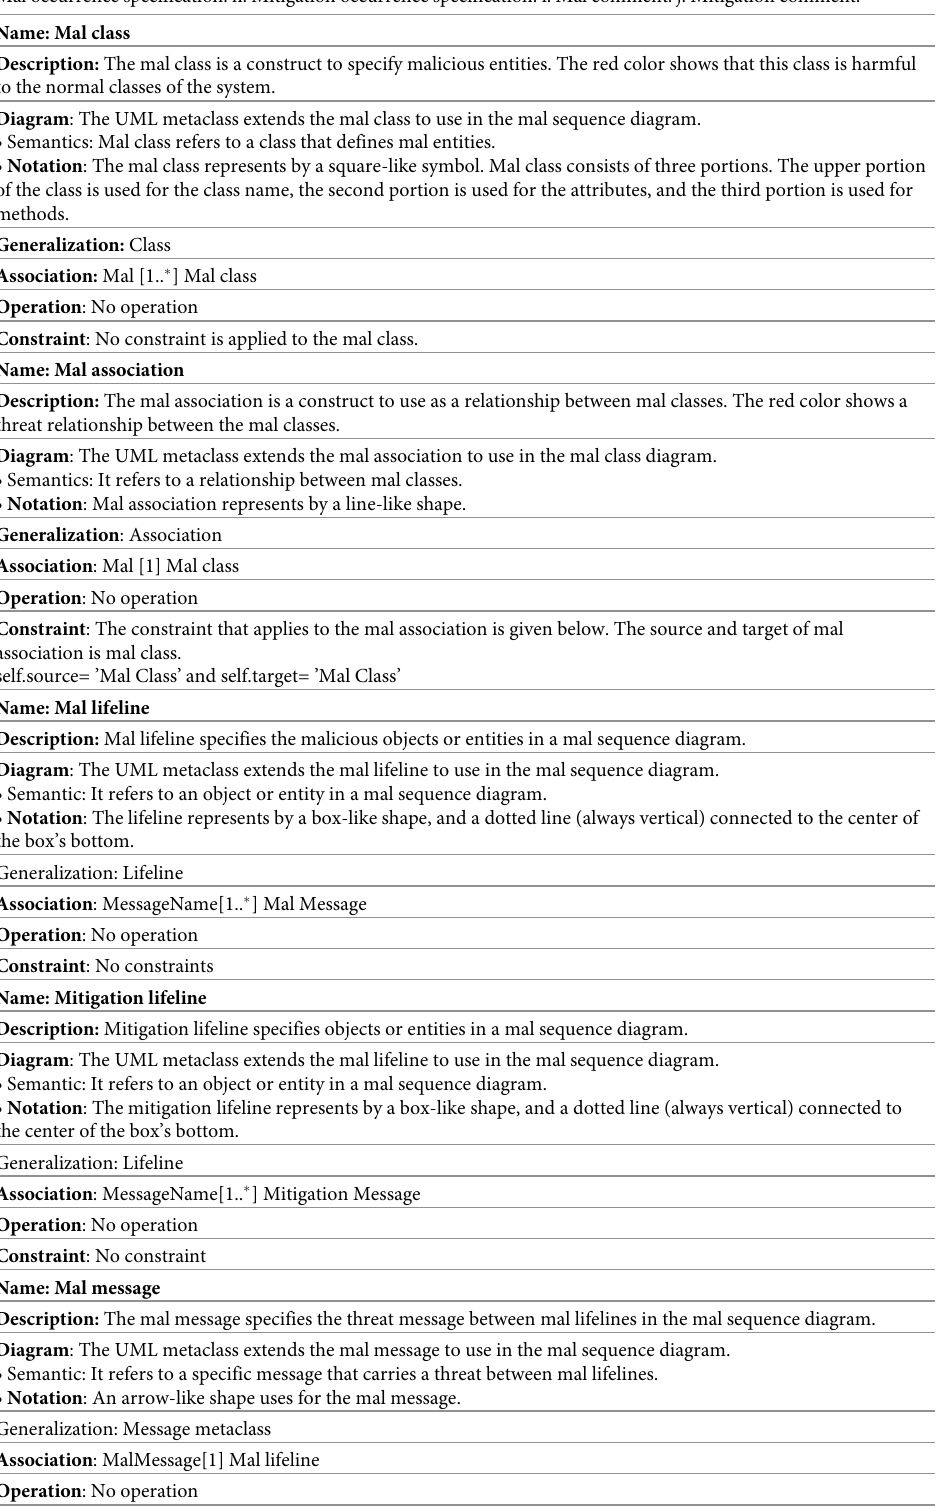
Table 2. a. Mal class. b. Mal association. c. Mal lifeline. d. Mitigation lifeline. e. Mal message. f. Mitigation message. g. Mal occurrence specification. h. Mitigation occurrence specification. i. Mal comment. j. Mitigation